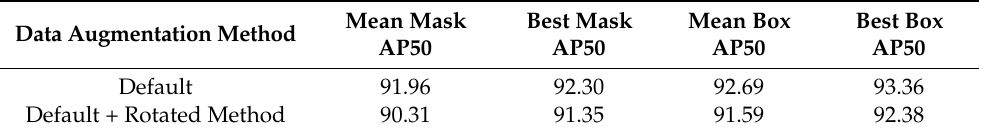
Table 8. Performances of the models for different augmentation methods.